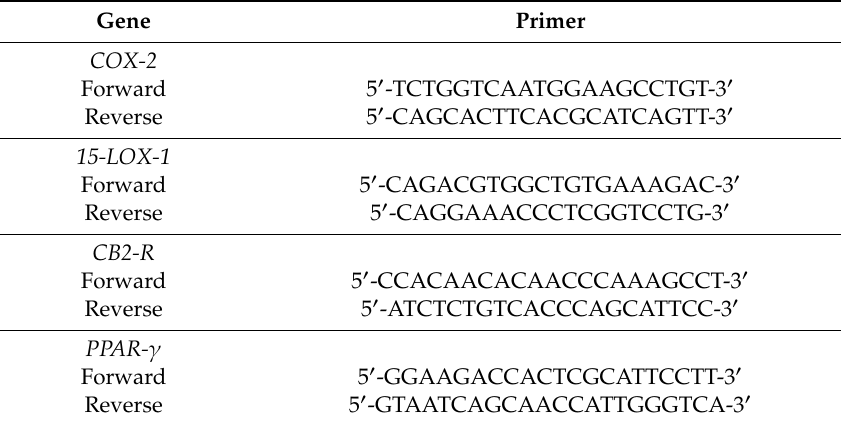
Table 2. Sequences of amplification